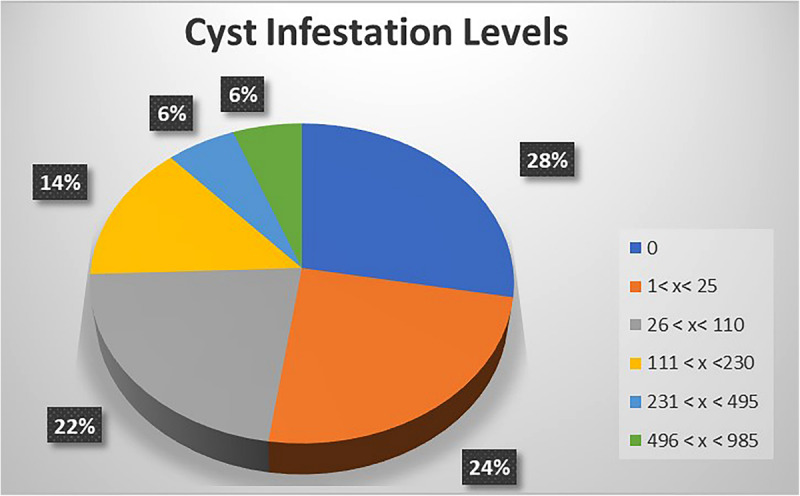
A representation of PCN cyst infestation levels across the 5 Sub-counties of Nyandarua County.